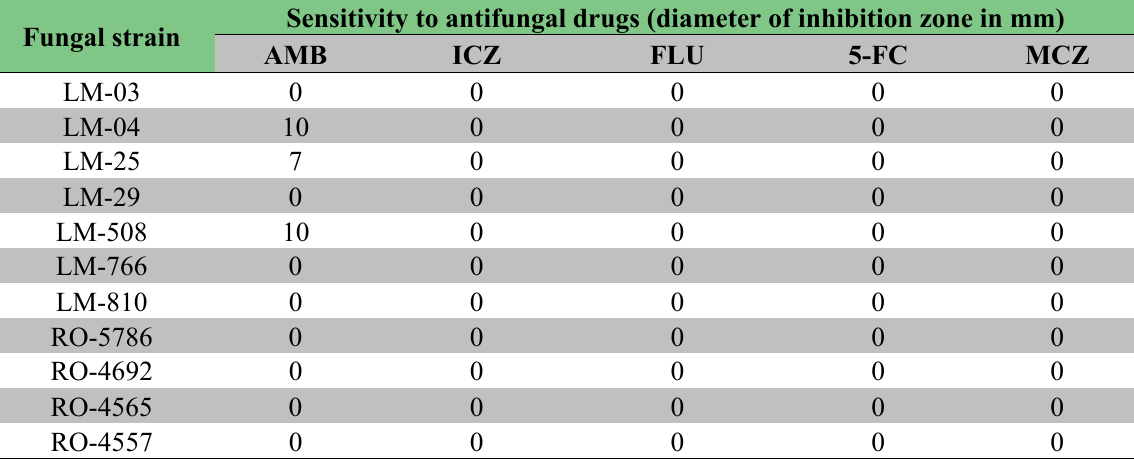
Table 1. Susceptibility of R. oryzae strains to antifungal drugs. Sensitivity to antifungal drugs (diameter of inhibition zone in mm) Fungal strain